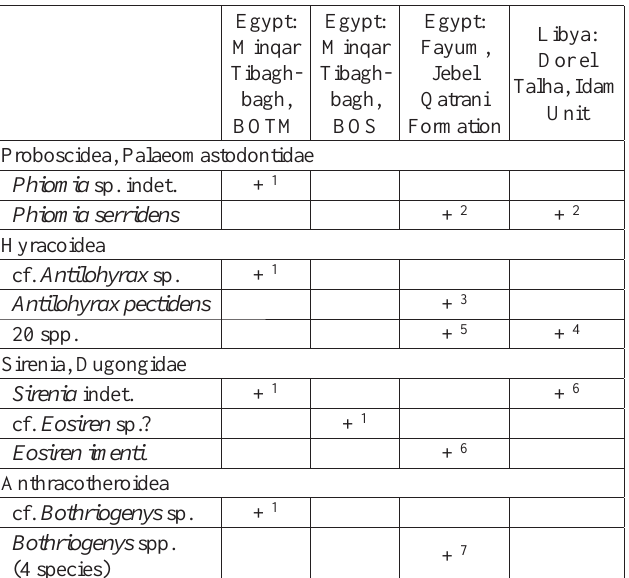
Table 6. Comparison of the mammal fauna from BOTM and BOS, early Oligocene, Minqar Tibaghbagh, Qattara Depression, Egypt, with mammal faunas from the Jebel Qatrani Formation, Fayum, Egypt and Dor El-Talha, Libya. 1 this paper; 2 Sanders et al. 2010; 3 Rasmussen and Simons 2000; 4 Rasmussen et al. 2008; 5 Rasmussen and